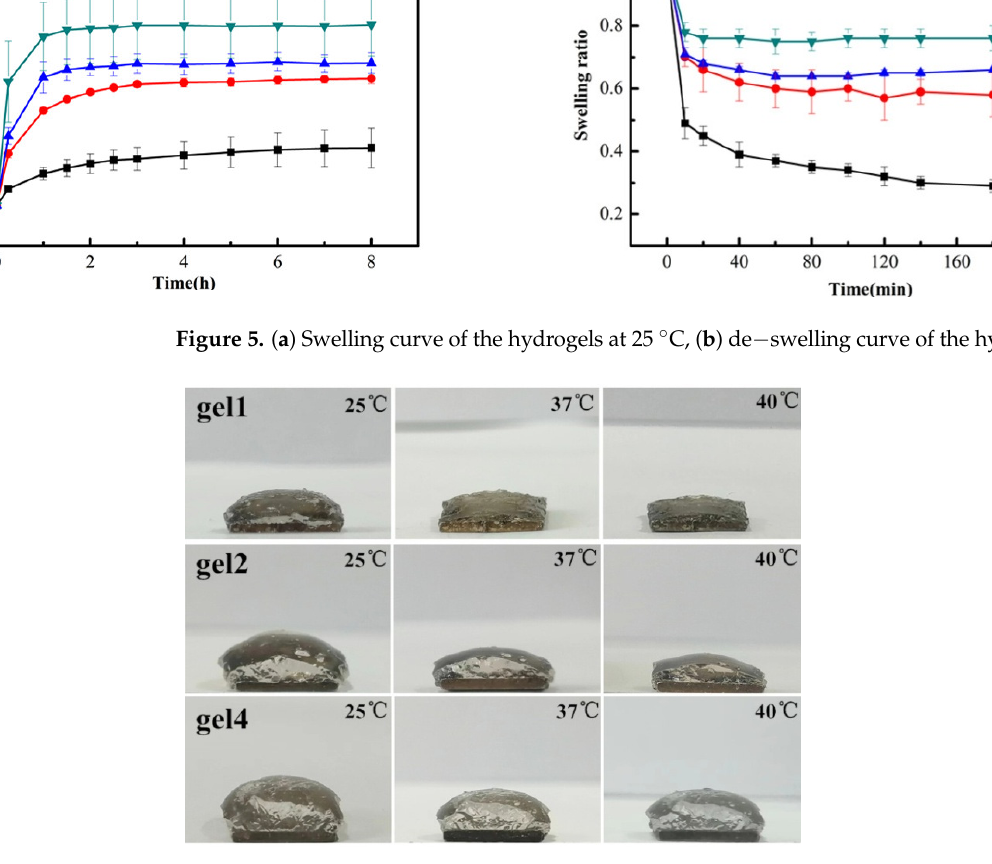
Figure 6. The macrostructure changes of gel1, gel2, and gel4 at 25 °C, 37 °C, and 40 °C.